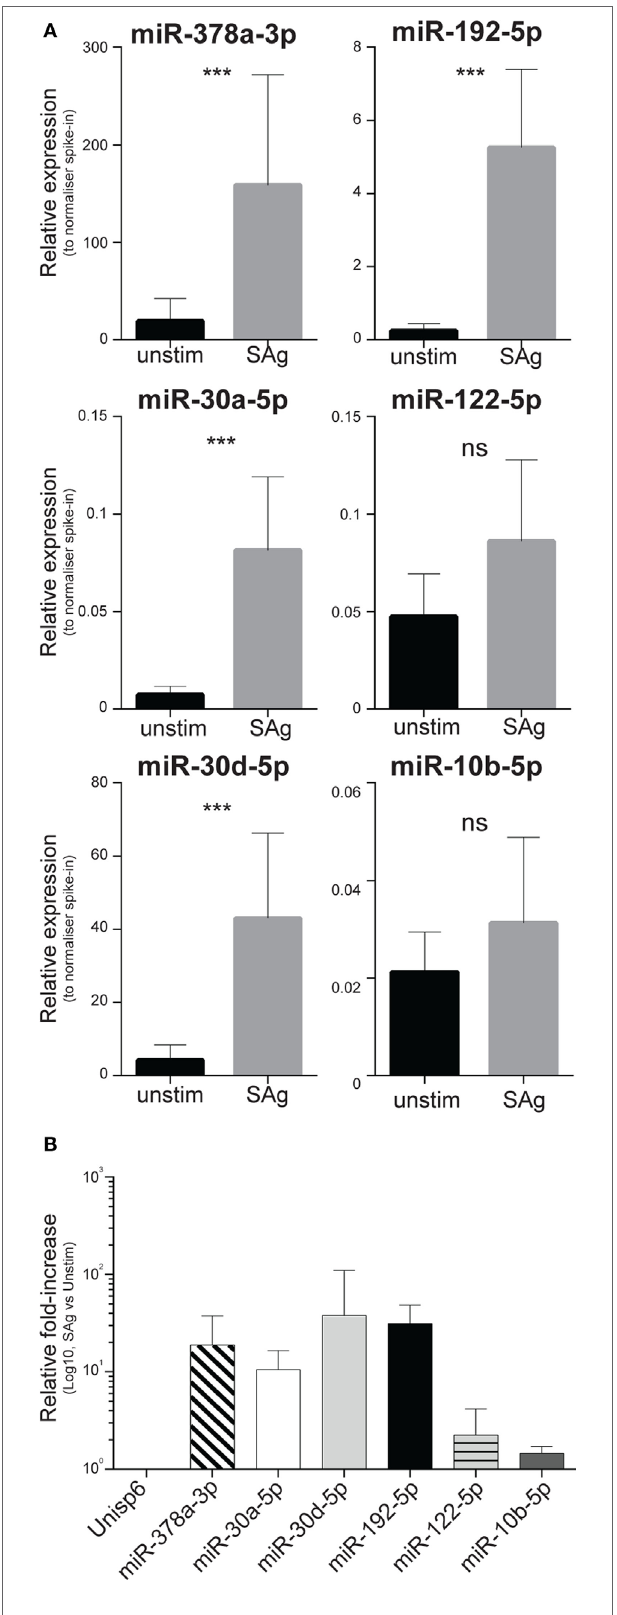
FigUre 6 | Levels of circulating inflammatory-relevant microRNAs affected by the severity of systemic inflammatory response syndrome (SIRS) are increased in supernatants of blood-derived immune cell cultures. PBMCs derived from 10 individuals were freshly purified from blood and equal cell numbers were then incubated in complete media in the presence of exosome-free bovine serum, strictly at the concentration of 2 × 10 6 cells/ml, in replicate wells. Half of the cultures were stimulated with the SPE-KL bacterial superantigen (SAg) from 5 days, in comparison to unstimulated controls (unstim). On day 5, cells were harvested and equal volumes of supernatants were recovered after two sequential spins prior to RNA extraction as detailed in the Section “Materials and Methods.” The presence of microRNAs regulated (miR-378a-3p, miR-30a-5p, miR-30d-5p, miR-192-5p, and miR-122-5p) or unaffected (miR-10b-5p) by the severity of non-infective SIRS was assessed in Q-PCR array in multiple biological replicates. (a) Within each donor’s specimen, crossing point (Cp) of a single miRNA is compared to the Cp of a spike-in RNA added to supernatants just prior to the RNA-purification to give delta Cp (dCp). dCp were then linearized to give the relative expression of individual miRNAs in supernatants from unstimulated (black bars; n = 10, 7, 5, 7, 10, 4, respectively, for miR-378a- 3p, miR-30a-5p, miR-30d-5p, miR-192-5p, miR-122-5p, and miR-10b-5p) compared to SAg-activated cells (gray bars; n = 10, 10, 8, 9, 10, and 9, respectively, for miR-378a-3p, miR-30a-5p, miR-30d-5p, miR-192-5p, miR-122-5p, and miR-10b-5p). (B) Average miRNA fold-induction in 4–10 individuals were calculated as the average ratio of miRNA levels detected